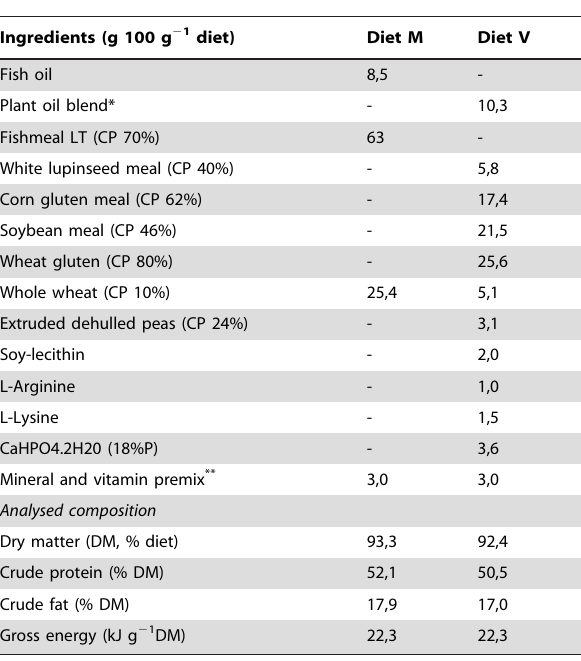
Table 1. Formulation, approximate crude protein (CP) levels of ingredients and analysed composition of the experimental diets M (fishmeal and fish oil-based) and V (all fishmeal and fish oil replaced by plant protein and plant oil